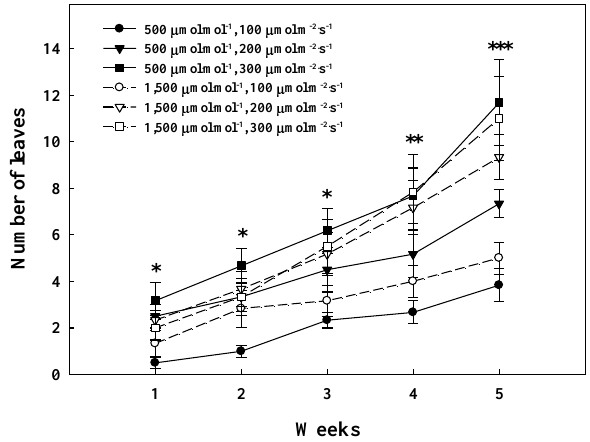
Figure 5. Changes in the number of leaves on Glehnia littoralis Fr. Schmidt ex Miquel, as affected by various CO 2 concentrations and light intensities. The error bars represent the standard deviation of the mean ( n = 3). *, **, *** Significant at p ≤ 0.05, 0.01, or 0.001, respectively.